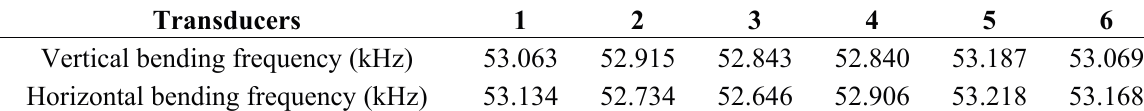
Table 1. The tested first bending resonance frequencies.